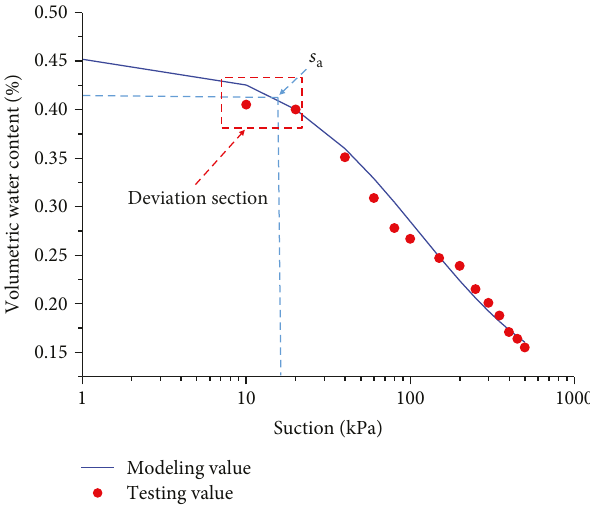
Figure 8: Result comparison at the void ratio of 0.8.